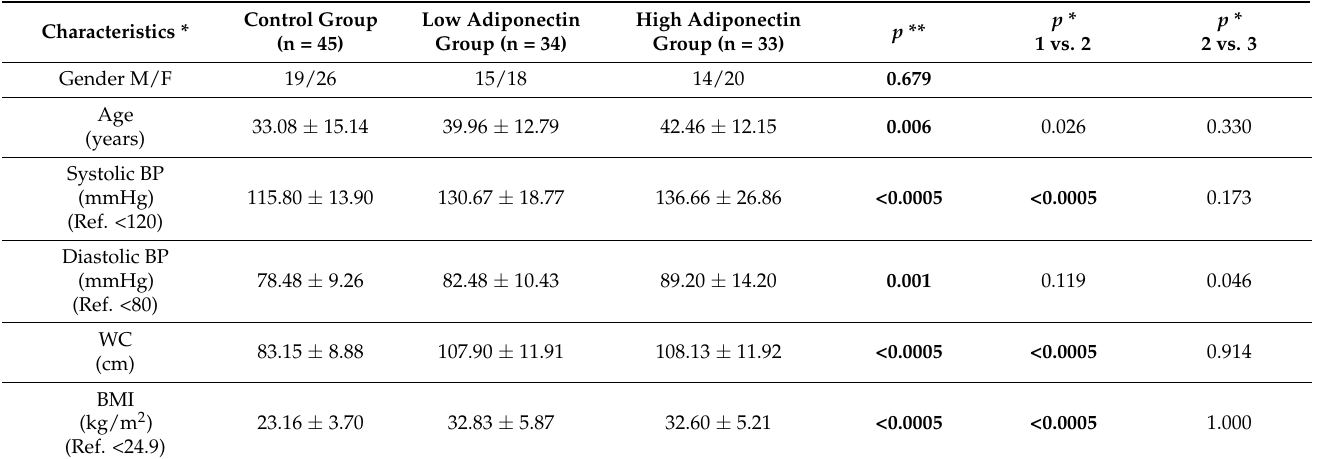
Table 3. Demographic and clinical characteristics of subgroups of patients with MS divided by mean adiponectin (cut off 80.0